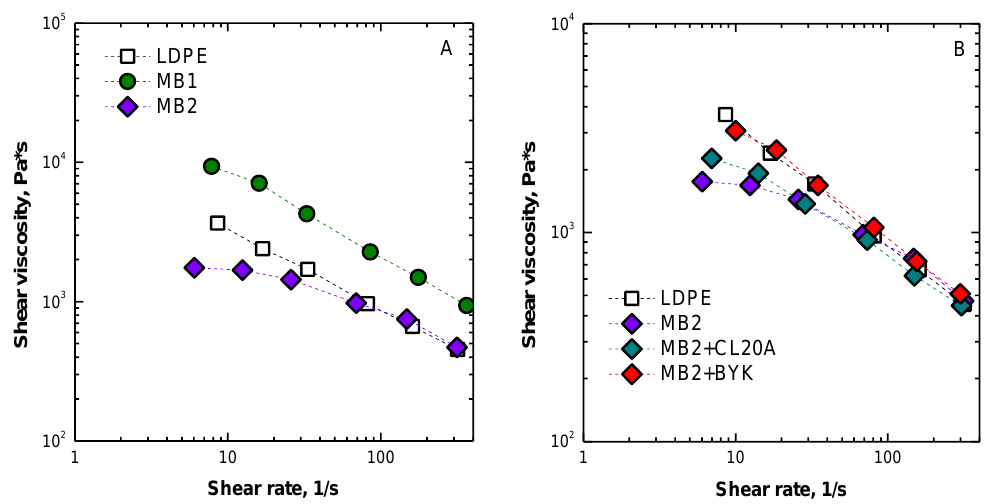
Figure 6. Shear viscosity as a function of shear rate for ( A ) unfilled polymers and ( B ) unfilled LDPE and MB2 and MB2-based bionanocomposites.